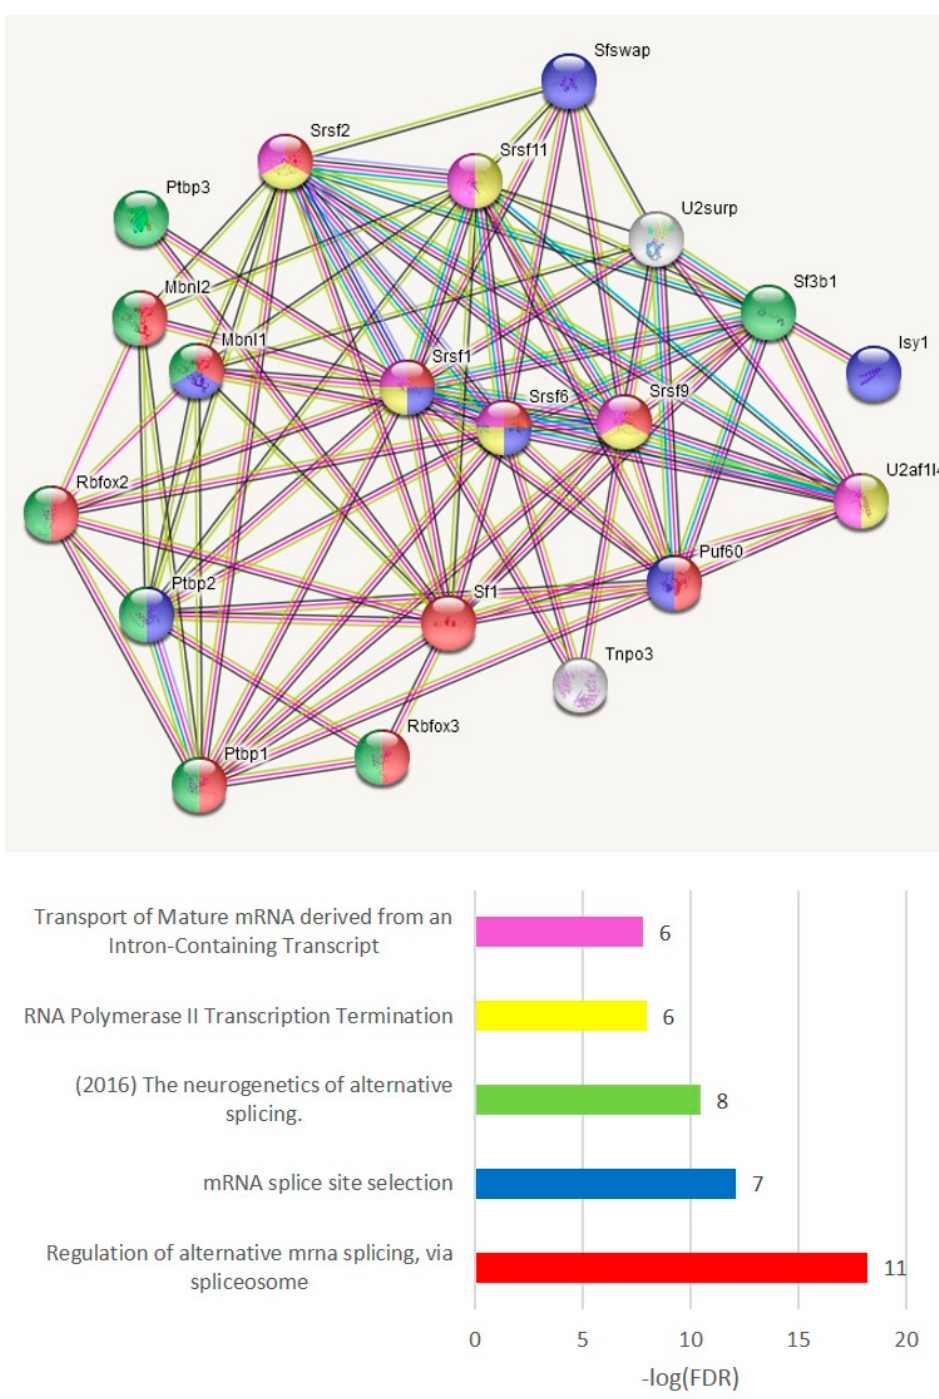
Figure 21. Network of 21 SF genes abundant in the AS2/NMD ES events observed in our samples (Table S8a) outlined by string-db.org. Color code corresponds to the bar plot. As is evident from Figure 22, 21 splicing factors (Table S8b) are distributed in a group-specific manner: AD subjects (blue) tended to locate in the left part of the plot, while aggressive ones clustered in the right side (red). The control mice (green) split into two subgroups (states), one with elevated Khdrbs3 (SLM2) and the other with elevated expres- sion of U2af2 , Sf1 , Rbfox1 , and Ptbp1 SF clusters. Srsf9 , Srsf11 , and Puf 60 (poly-U binding